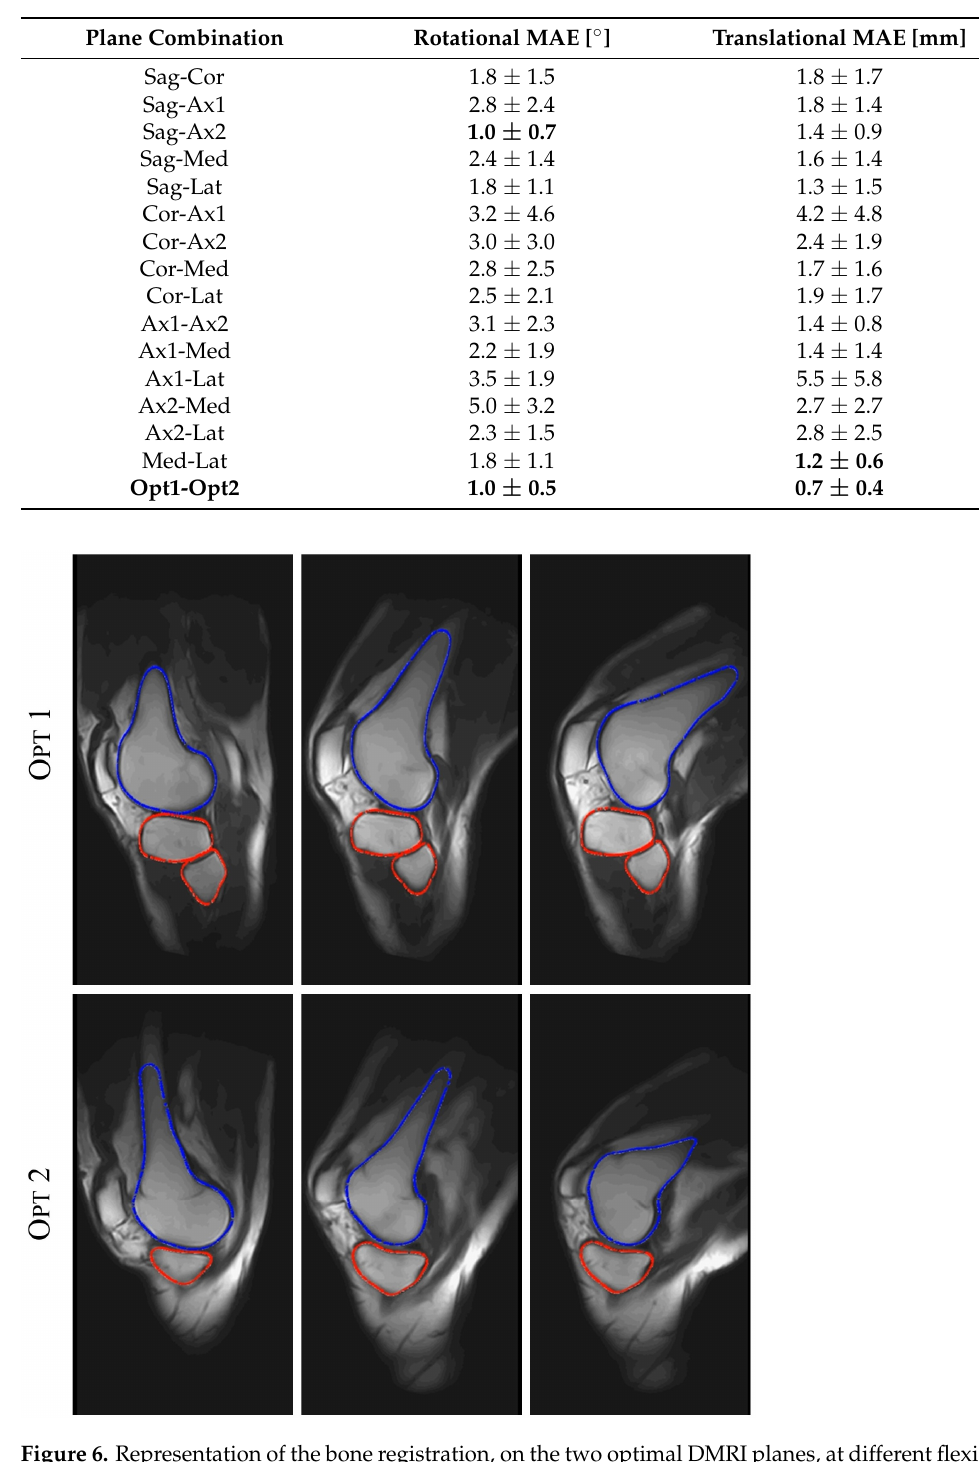
Table 1. Rotational and translational MAE for each of the tested combinations of DMRI planes.